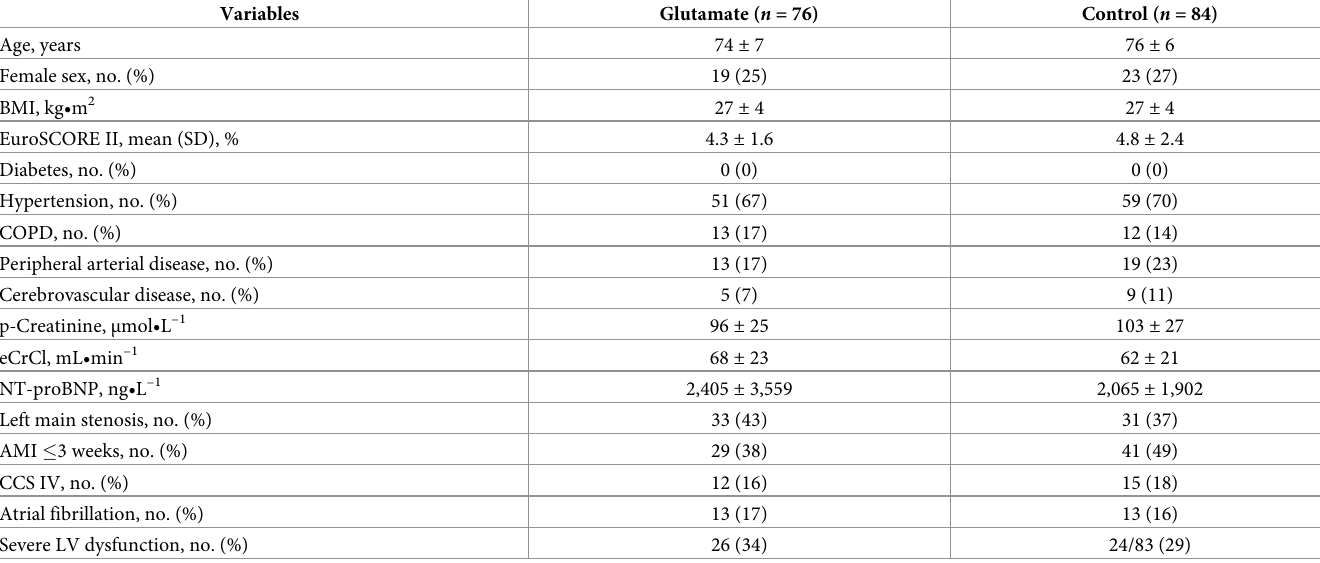
Table 3. Preoperative characteristics of patients without diabetes in the glutamate group and in the control group (saline).